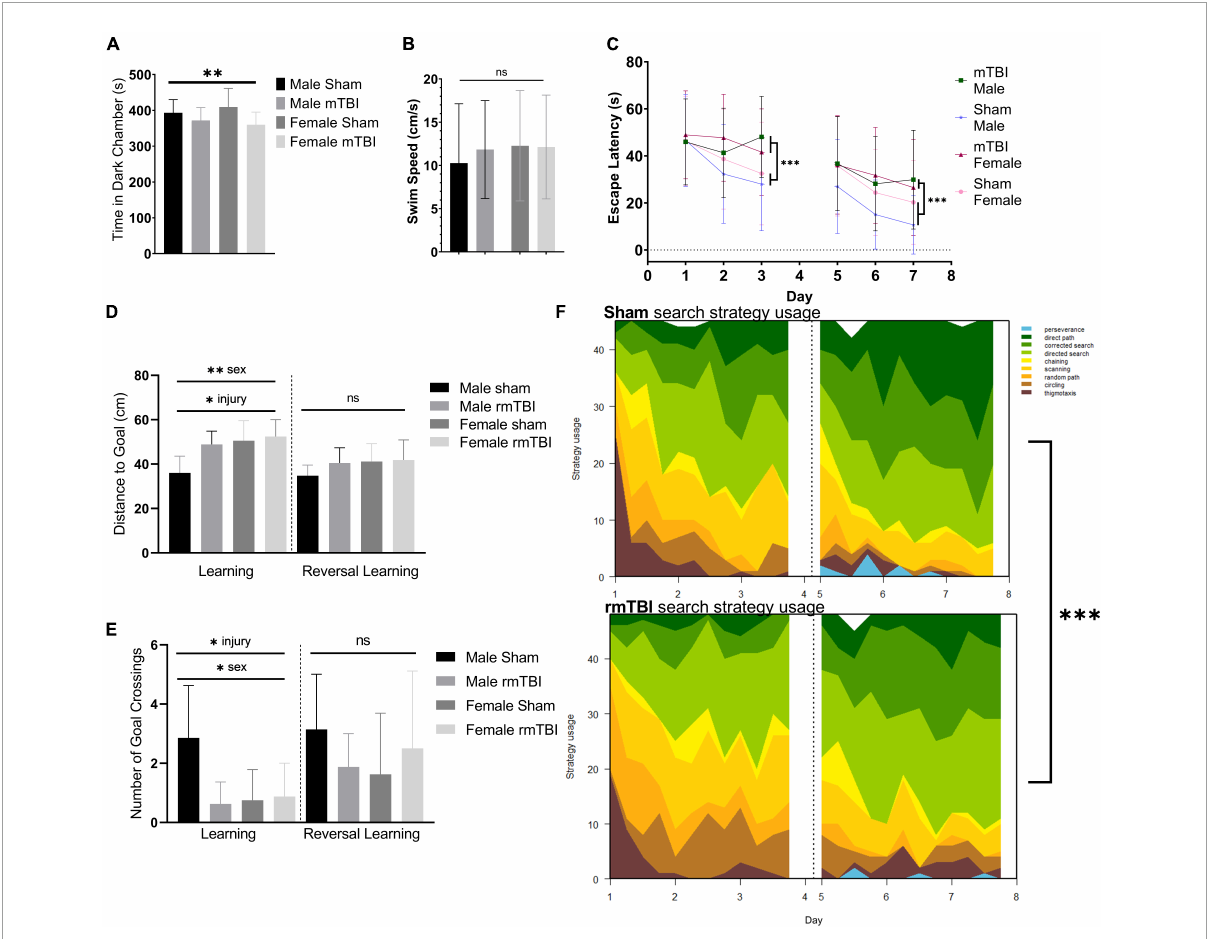
FIGURE2 Sex-specific cognitive dysfunction and behavioral disinhibition 1 week after rmTBI. In the light-dark box test (A) , rmTBI mice spent significantly longer in the light chamber compared to shams ( p = 0.04, main effect of injury, two-way ANOVA), with no main effect of sex. In the Morris Water Maze (MWM), no significant differences in swim speed were present between groups (B) . In the learning and reversal learning trials, rmTBI mice spent significantly longer to reach the platform compared to shams ( p < 0.001, main effect of injury, three-way ANOVA) over trial days ( p < 0.001, main effect of training day, three-way ANOVA) (C) . There was a small effect of sex nearing significance ( p = 0.1, three-way ANOVA), and therefore a significant interaction between injury, sex, and training day ( p = 0.05, three-way ANOVA) reflecting baseline differences between male and female sham mice. On the learning probe days, rmTBI mice had a significantly higher distance to the goal compared to shams ( p < 0.01, main effect of injury, two-way ANOVA) (D) . This measurement also showed a sex difference ( p < 0.01, main effect of sex, two-way ANOVA) and a significant interaction between sex and injury ( p = 0.05, two-way ANOVA). Post-hoc testing indicates a significant difference between male shams vs male rmTBI mice ( p = 0.01, Tukey HSD), male shams vs female shams ( p = 0.005, Tukey HSD), and male shams vs female rmTBI mice ( p = 0.001, Tukey HSD). Similarly, rmTBI mice had significantly less number of goal crossings compared to shams ( p = 0.02, main effect of injury, two-way ANOVA) (E) with an effect of sex ( p = 0.04, main effect of sex, two-way ANOVA) and a significant interaction between sex and injury ( p = 0.01, two-way ANOVA). Similar to distance to goal, post-hot testing indicates a significant difference between male and female shams ( p = 0.01, Tukey HSD), male shams and male rmTBI mice ( p = 0.007, Tukey HSD), and male shams and female rmTBI mice ( p = 0.02, Tukey HSD). Reversal probe tests were not significantly different between shams and rmTBI mice. Using a machine learning classifier (RTrack), search strategy was assessed over training days between sham and rmTBI mice, without consideration for sex (F) . Overall, rmTBI mice used more goal-oriented strategies (perserverence, direct path, corrected search, and directed search) and less procedural (chaining, scanning) and non-goal-oriented (random path, circling, thigmotaxis) strategies compared to sham mice in total ( p < 0.0001, x 2 = 39.95, Chi Square). Significant differences between rmTBI and sham mice were found on day 2 ( p = 0.003, x 2 = 11.83), day 3 ( p < 0.0001, x 2 = 22.51), day 6 ( p = 0.02, x 2 = 8.25), and day 7 ( p = 0.004, x 2 = 11.25). Error bars represent standard deviation with n = 8 per group. Indication of